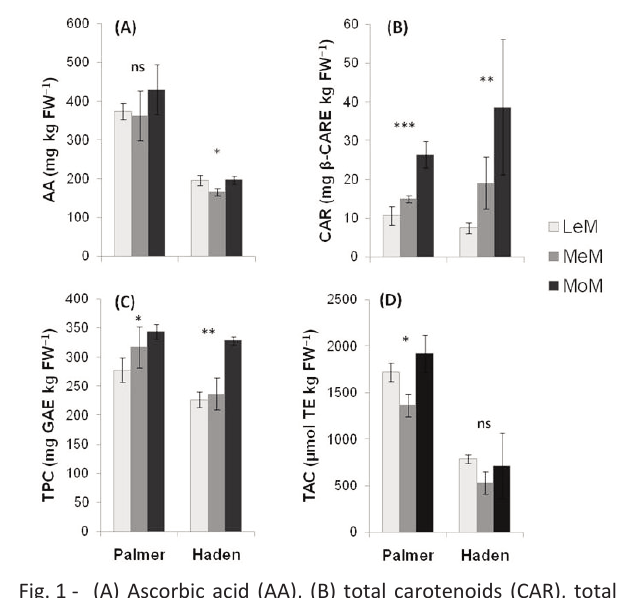
Fig. 1 - (A) Ascorbic acid (AA), (B) total carotenoids (CAR), total phenol content (TPC) and total antioxidant capacity (TAC) in ‘Palmer’ and ‘Haden’ mangoes in function of µ a 540 maturity class (LeM, less mature; MeM, medium mature; MoM, more mature). Bars refer to SE . Within each cultivar ANOVA results are indicated as follows: *,